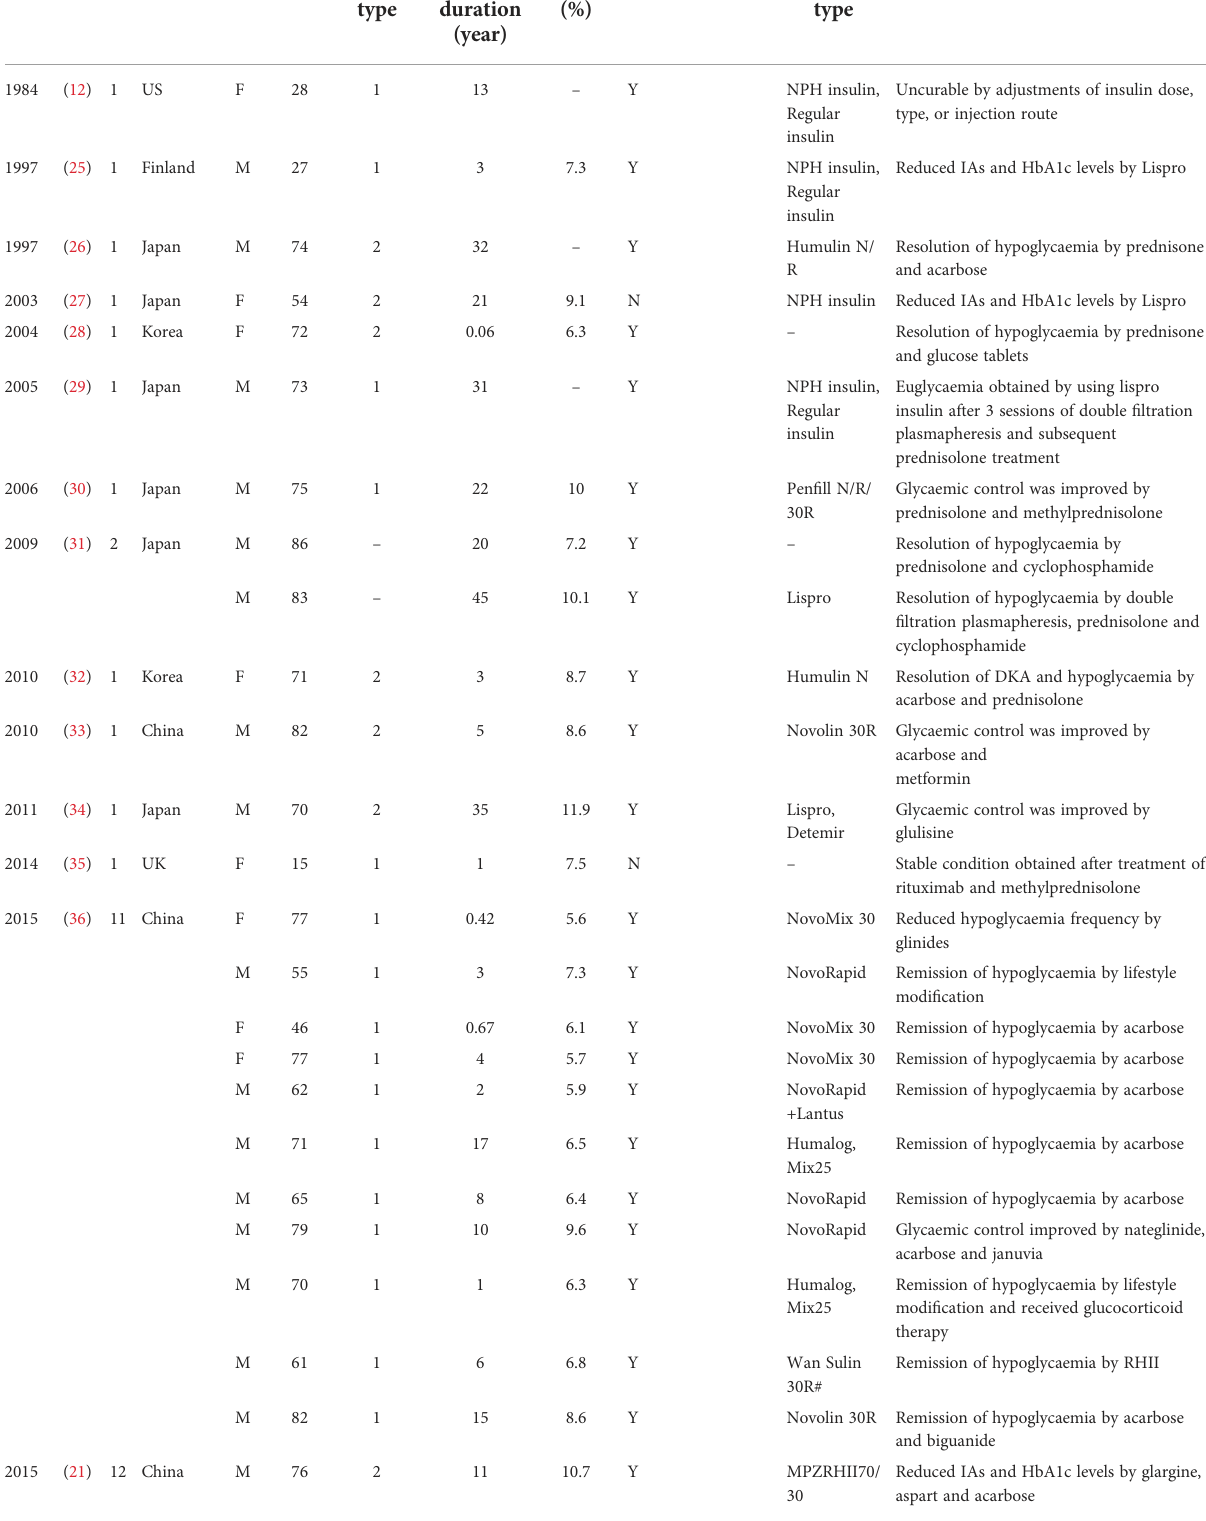
TABLE 2 Literature review of diabetic cases with exogenous insulin antibody